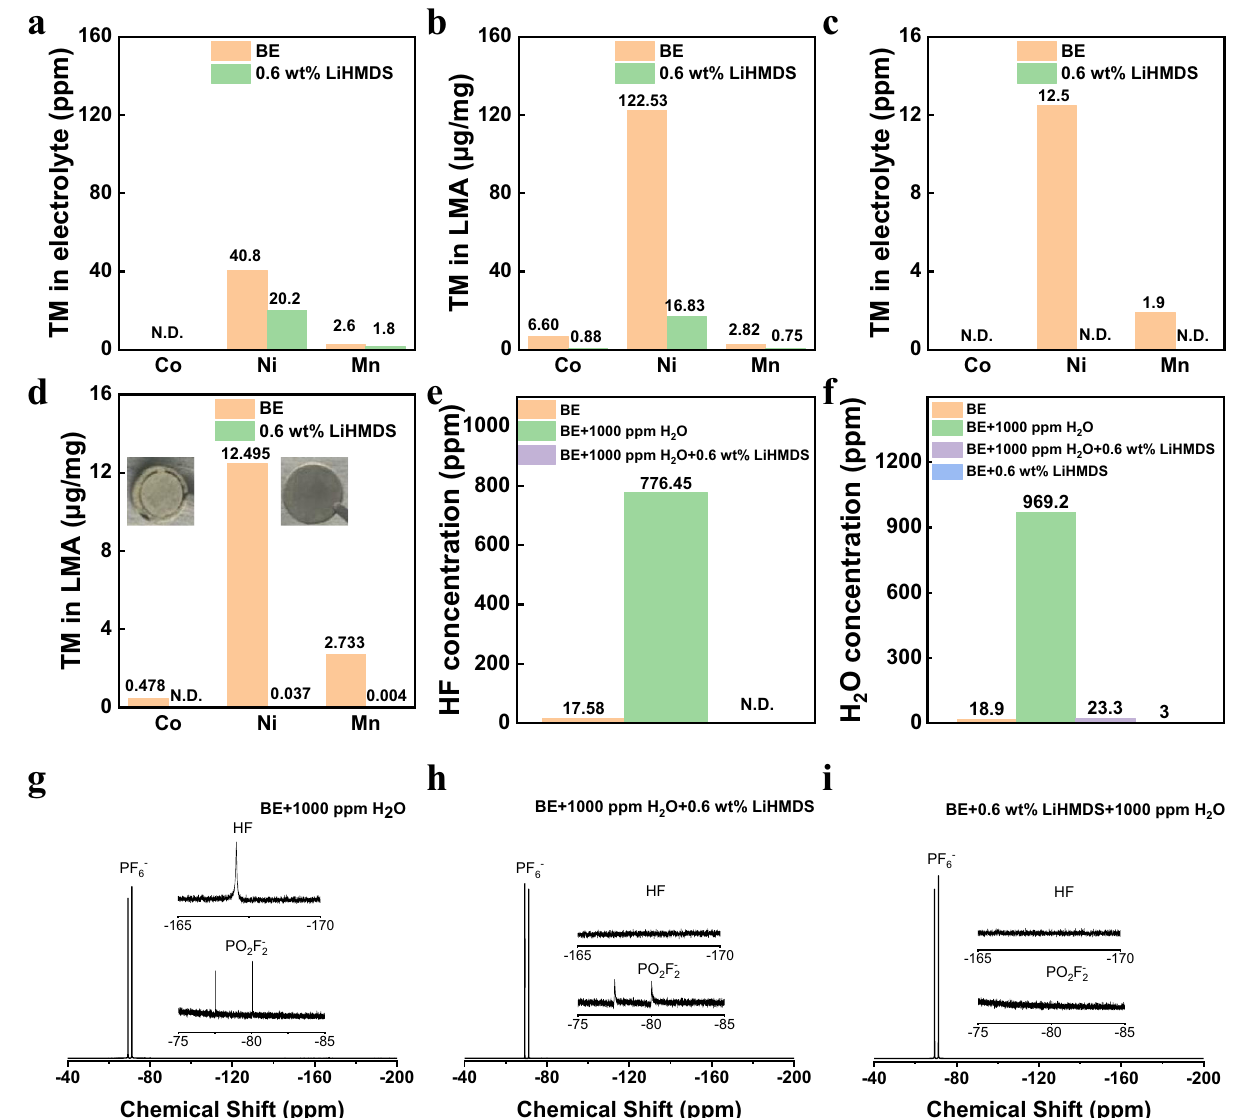
Fig. 4 | Ex situ measurements of the cycled electrolyte solutions and Li metal electrodes. ICP-MS analysis of cycled a electrolyte and b LMA after 100 cycles at 60°C, the charging/discharging current were 180mAg − 1 /180mAg − 1 , the cell was disassembled at fully discharged state. ICP-MS analysis of c electrolyte and d LMA after rest at open circuit voltage for 7 days at 60°C. e HF concentration of